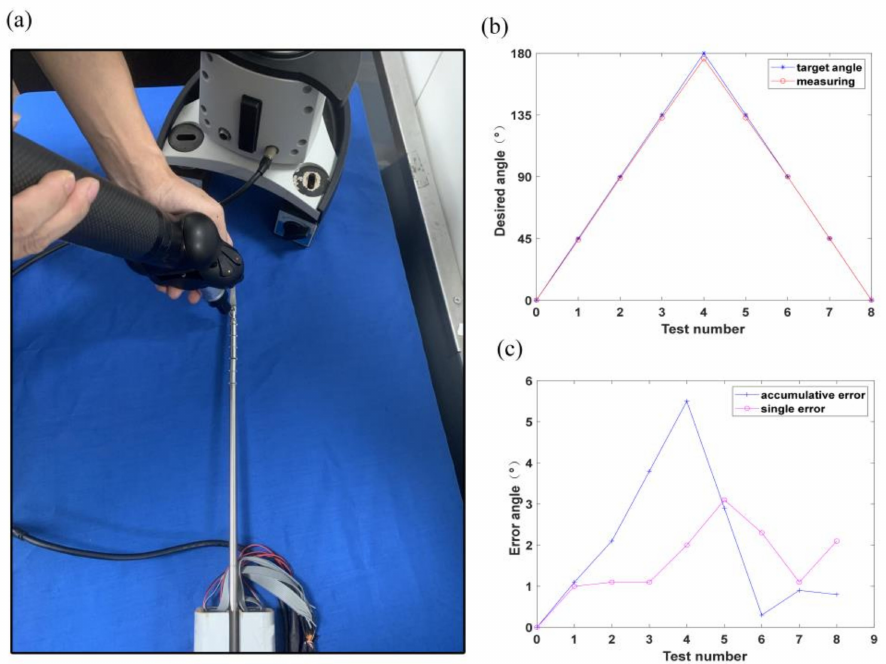
Figure 12. Tests of forceps rotation: ( a ) measurement of the angle of the rotation axis; ( b ) rotational measurement error; ( c ) rotational measurement